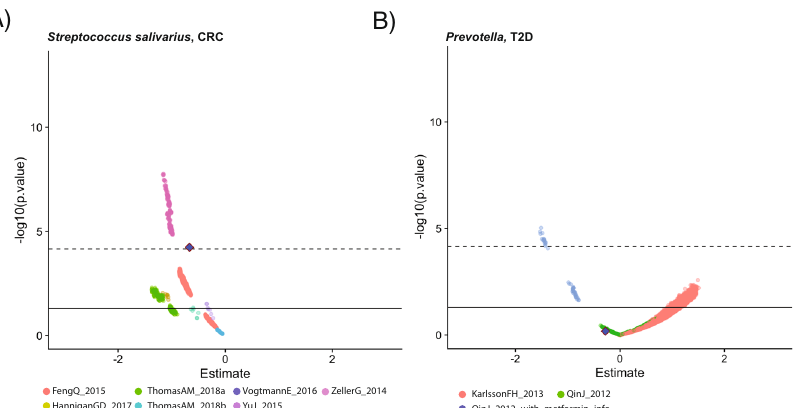
Fig. 3 Examples of associations of varying strength. Example of a robust ( A ) and nonrobust ( B ) association as identi fi ed by modeling vibration of effects. Each point represents the association deriving from multiple linear regression between the disease and microbial feature of interest for a different modeling strategy. Y axes are nominal log 10 P values. Solid line is nominal statistical signi fi cance ( P < 0.05). X axes are the beta-coef fi cient on the binary, independent disease variable of interest. Dotted lines represented the false-discovery rate-adjusted P values. Point colors correspond to cohorts. The solid blue diamond marks the P value and estimates achieved through meta-analysis across all cohorts. The species listed in A was included in the downstream analysis, as it exhibited meta-analytic false-discovery rate (FDR)-adjusted statistical signi fi cance, whereas the species in B was not included, as it was not FDR-signi fi cant and was not robust, as nominally signi fi cant opposite sign results (a Janus Effect) could be achieved with differing model speci fi